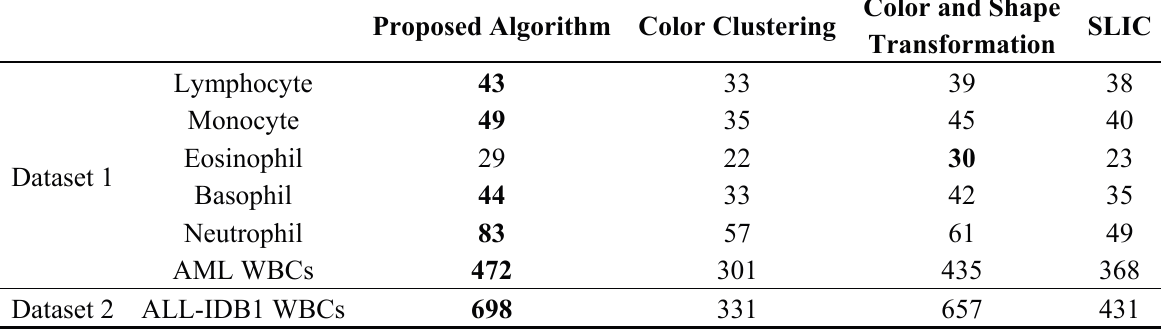
Table 5. Quantitative comparison in different cell types in two